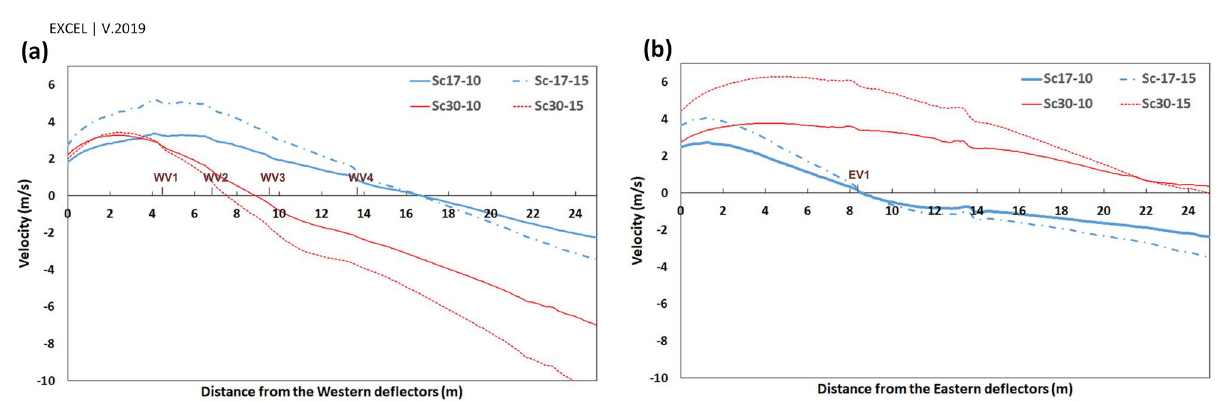
Figure 13. V y ′ on the profiles parallel and near the ( a ) western and ( b ) eastern wall, behind the